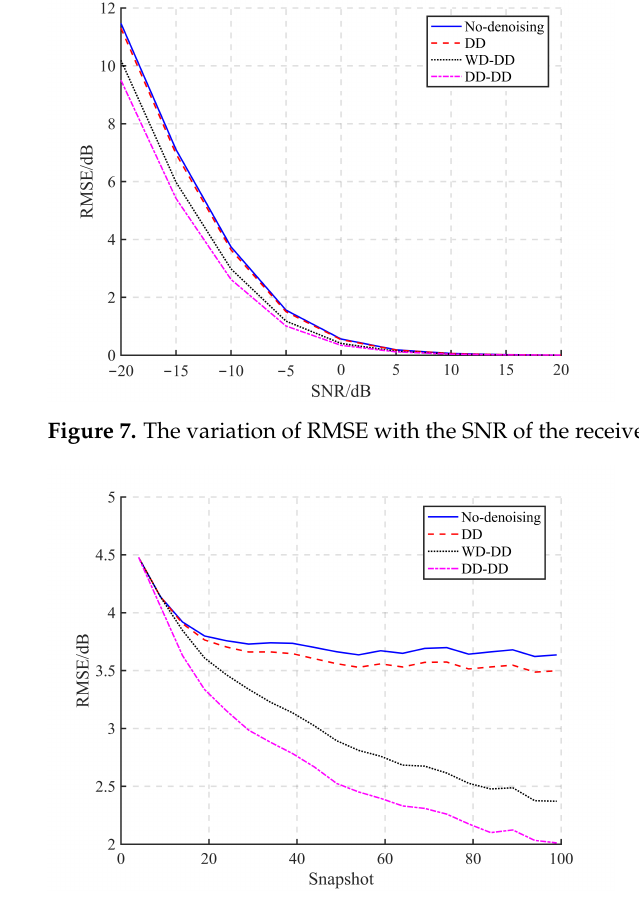
Figure 8. The variation of RMSE with the number of snapshots.